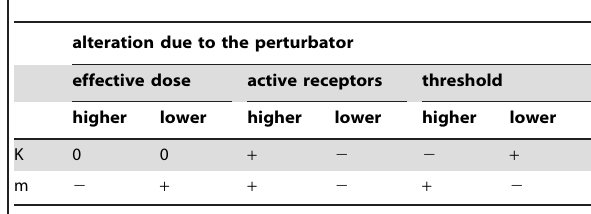
Table 2. Variations ( + : increase; 2 : decrease; 0: no change) in the parameters of the response to an effector, as described by the equation (7), due to the presence of an agent which produces the specified perturbations.